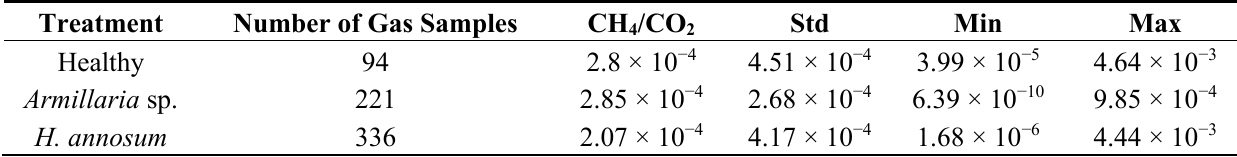
Table 1. Volumetric ratio of CH 4 to CO 2 : mean, standard deviation, minimum and maximum of all field samples